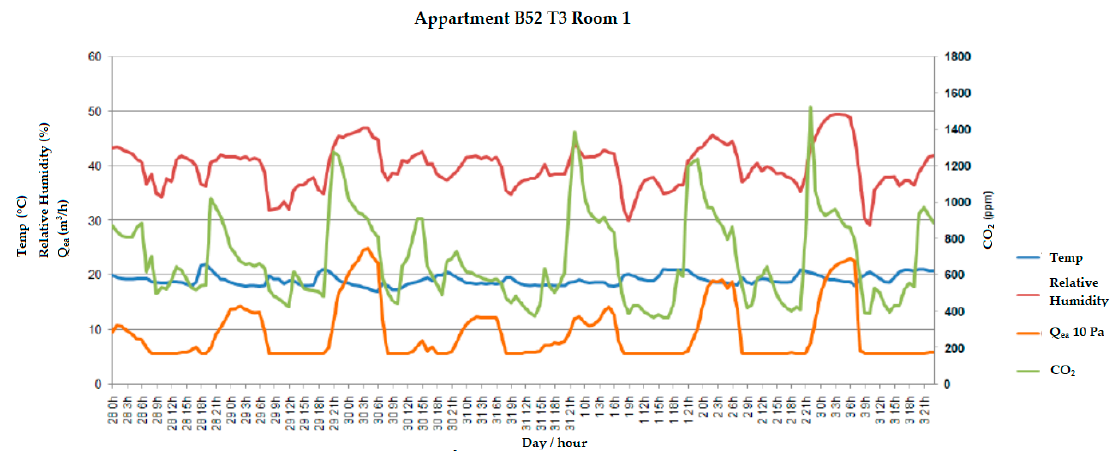
Figure 13. CO 2 , temperature, Q@10Pa, and relative humidity distribution during one week of monitoring